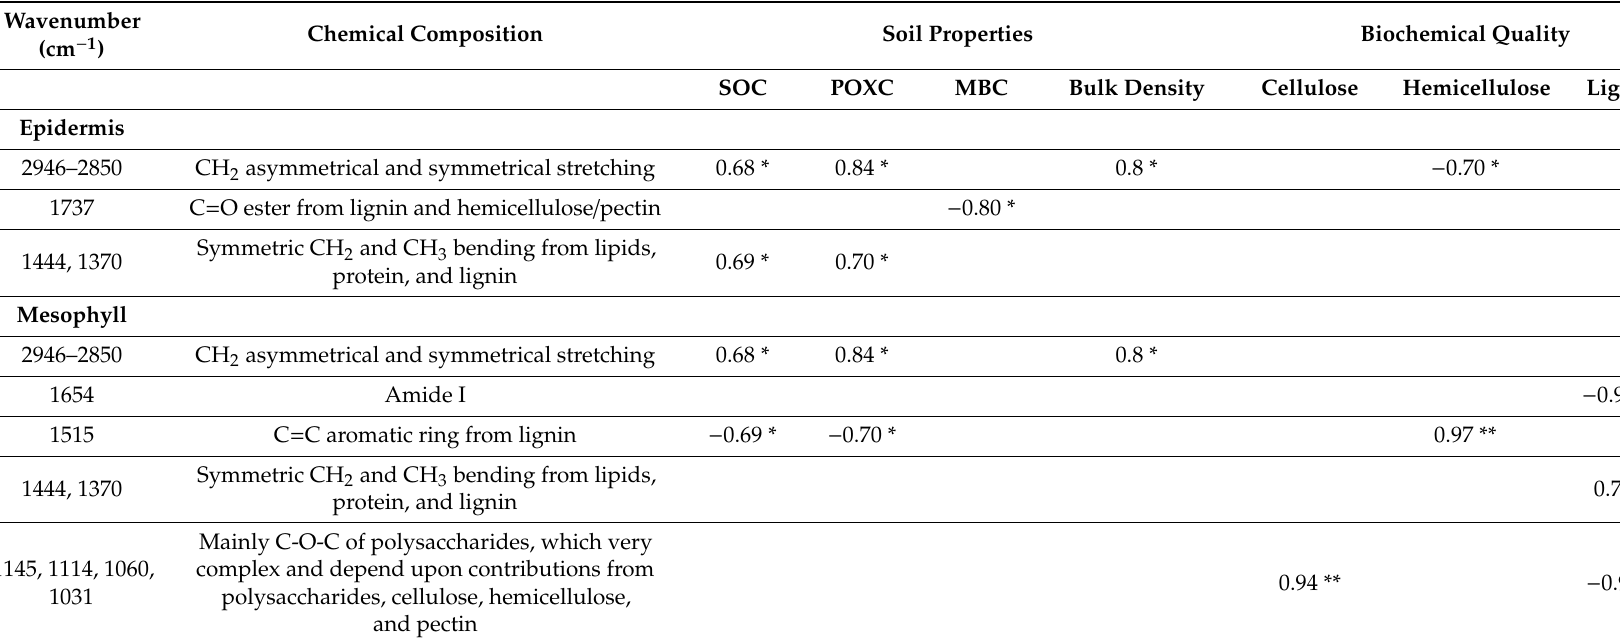
Table 6. Correlations between absorbance intensity of epidermis and mesophyll of rubber tissue reflectance, with synchrotron-based Fourier transform infrared (Sr-FTIR) bands representing organic chemical composition, and certain soil properties (* p < 0.05, ** p < 0.001).